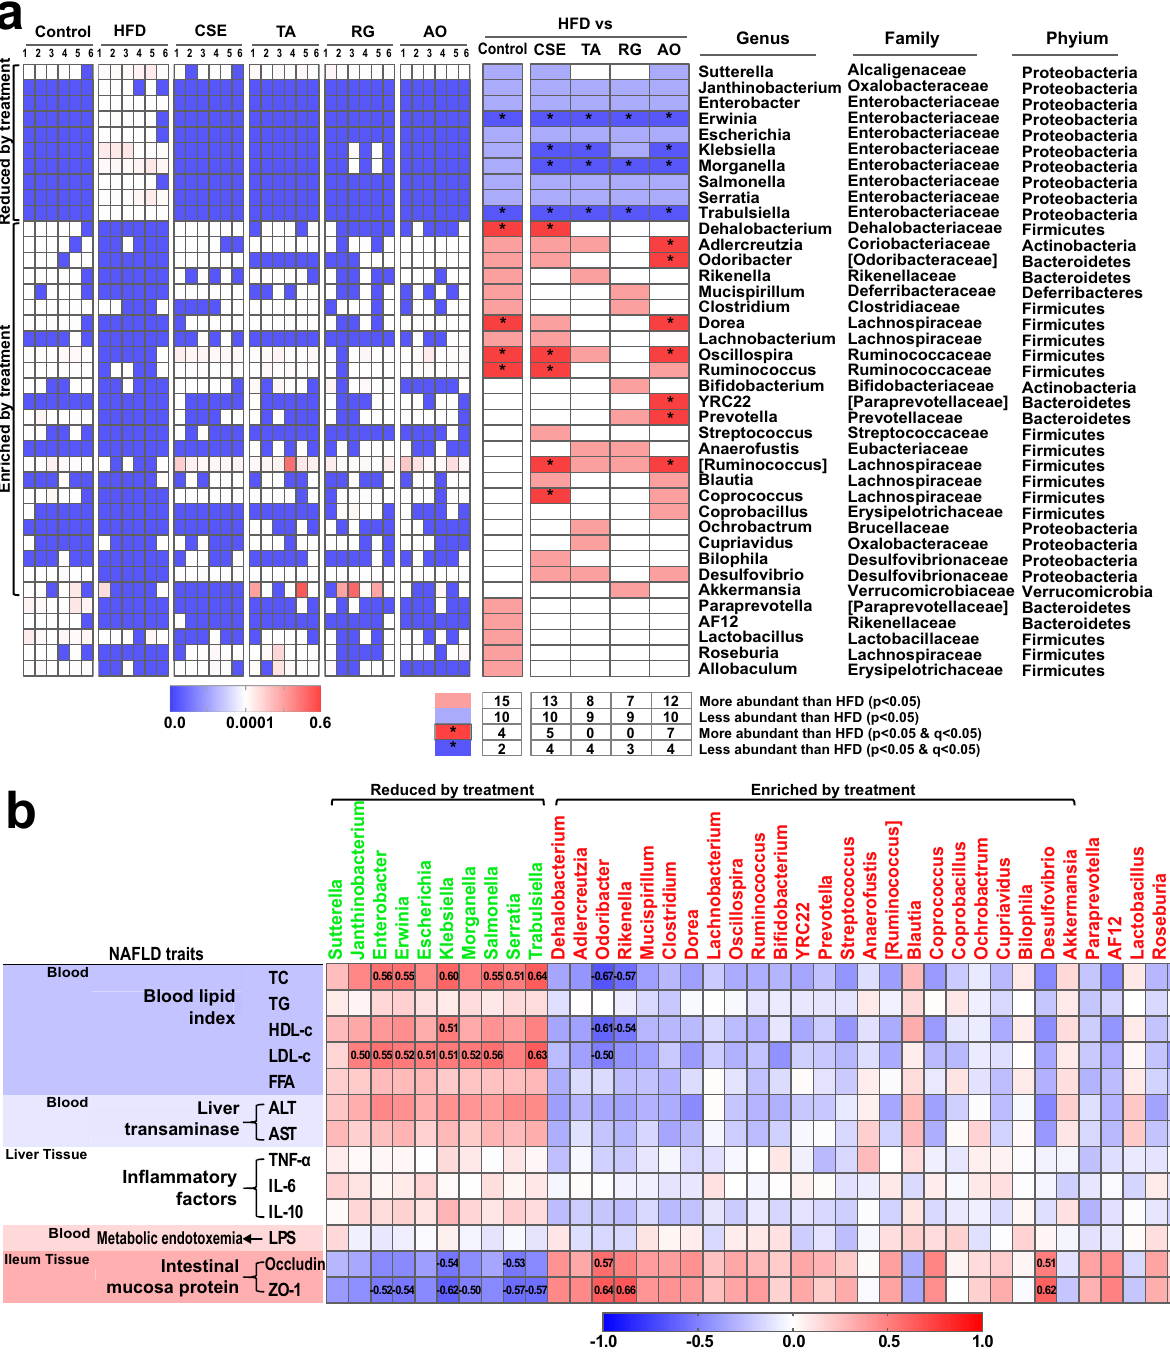
Fig. 5 Genera changes by HFD and extracts or compounds administration. Genera changes by HFD and extracts or compounds administration ( a ). Heatmaps on the left show that relative abundance of bacterial genera was altered. Statistical analysis of differences between groups was performed using Metastats; in the image, red represents increased relative abundance, blue represents decreased, and *represents a signi fi cant change in genus (both P < 0.05 and Q < 0.05). The corresponding genus information is on the right. Spearman correlations among 39 key genera and NAFLD-related indicators ( b ). Signi fi cant correlation coef fi cients between genera are indicated by the numbers in the